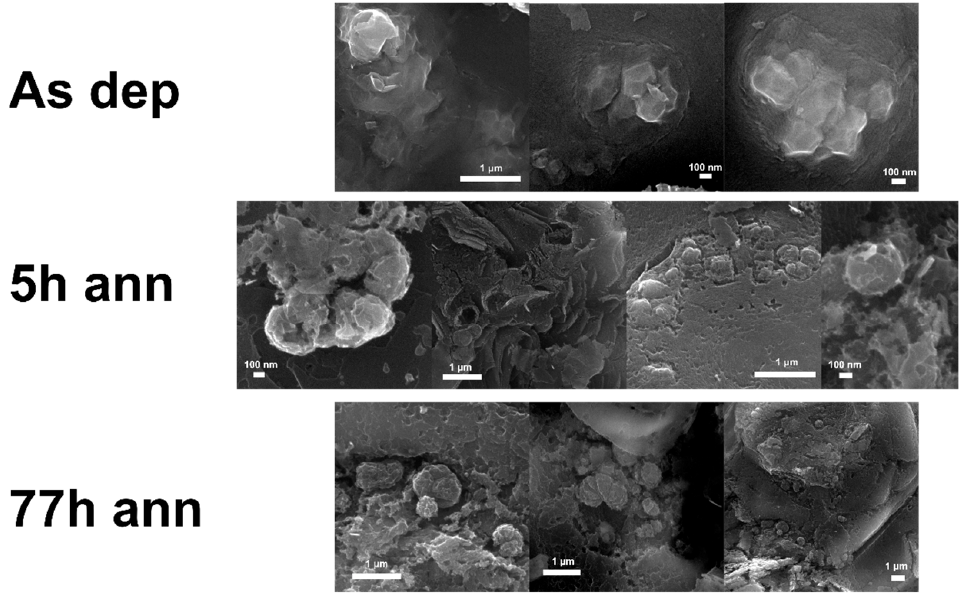
Figure 3. Typical SEM images for the as-deposited sample and after annealing at 425 °C for 5 h and 77 h.